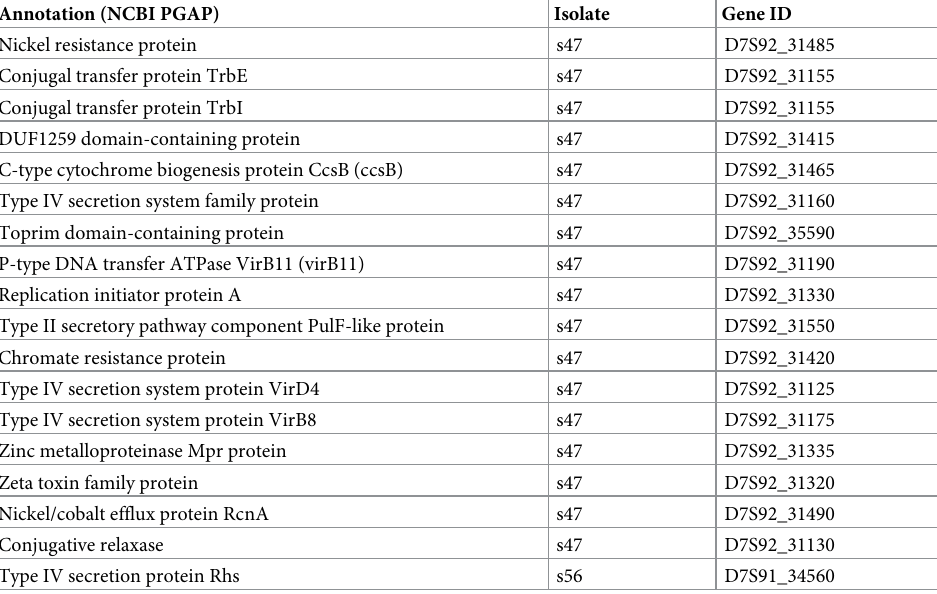
Table 4. ISS-derived B . contaminans singleton-GC functional